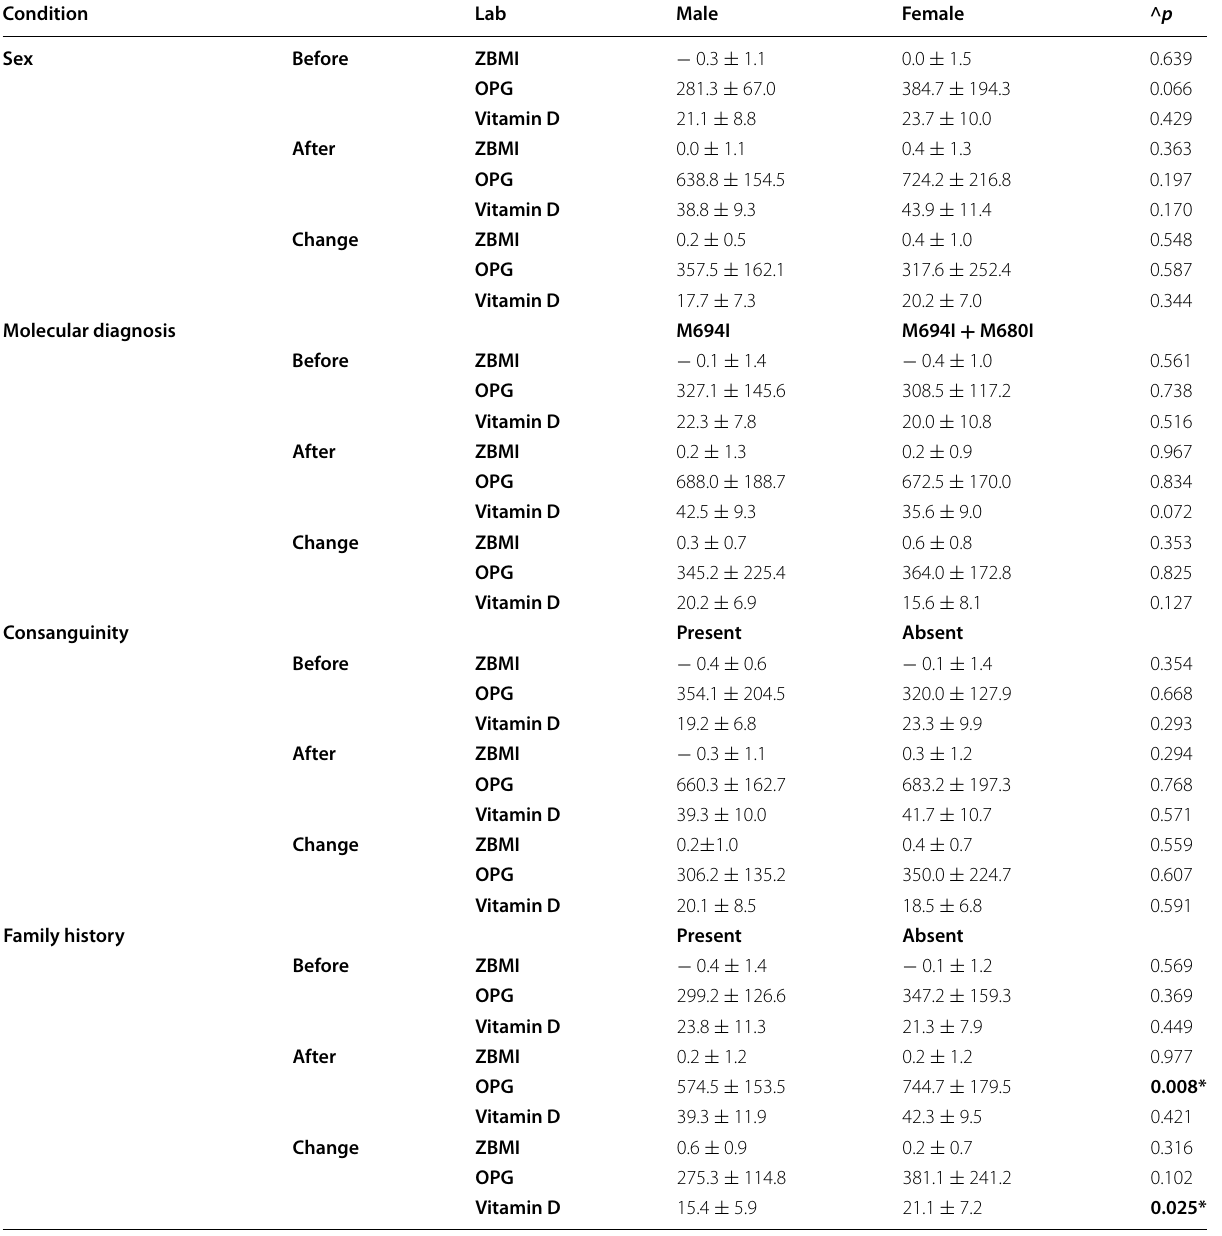
Table 5 Comparison between ZBMI, OPG, and vitamin D serum levels according to different demographic and molecular